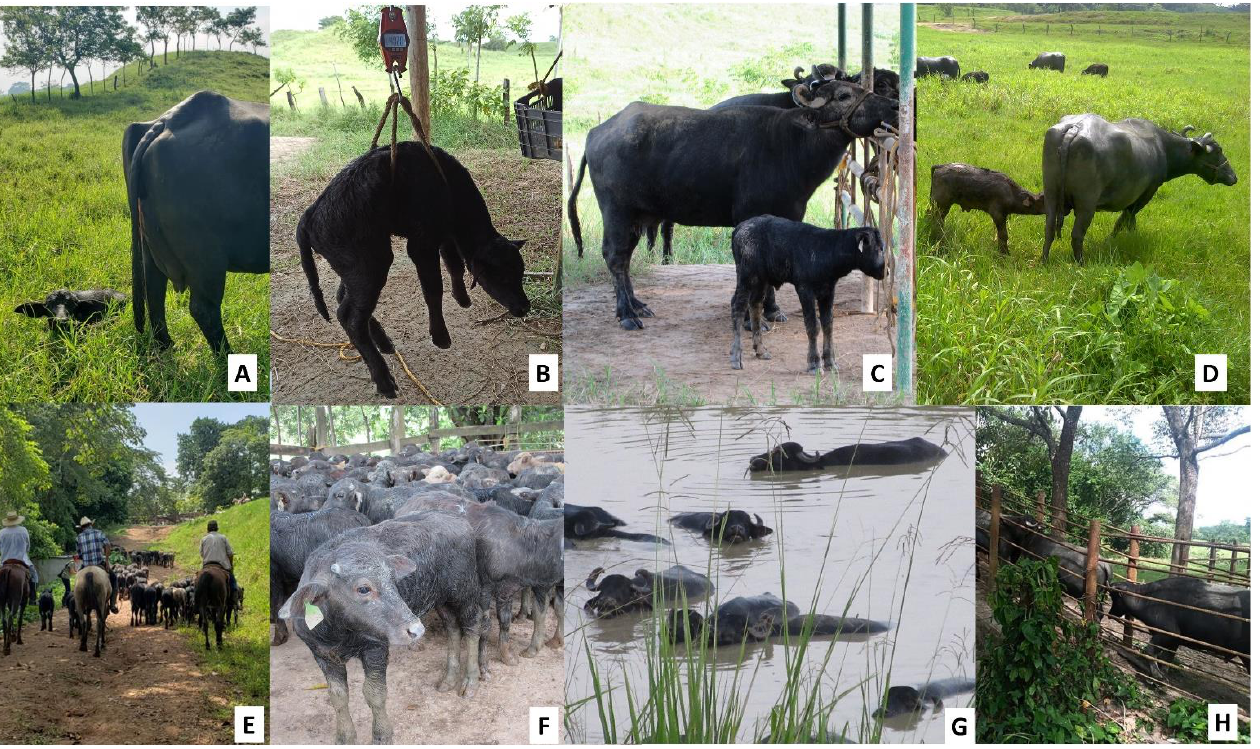
Figure 13. Areas of dual-purpose buffalo production systems. ( A ) Potrero destined for prepartum and delivery days. ( B ) Calf weighing area. ( C ) Manual milking with the presence of calf. ( D ) Grazing in the pasture of the dam in the company of the calf. ( E ). Herding of calves on horseback. ( F ) Confinement of calves after grazing with the dam. ( G ) Specific paddocks for steers where the characteristics that allow their natural behavior of thermoregulation are provided. ( H ) Loading of finished animals or intermediate